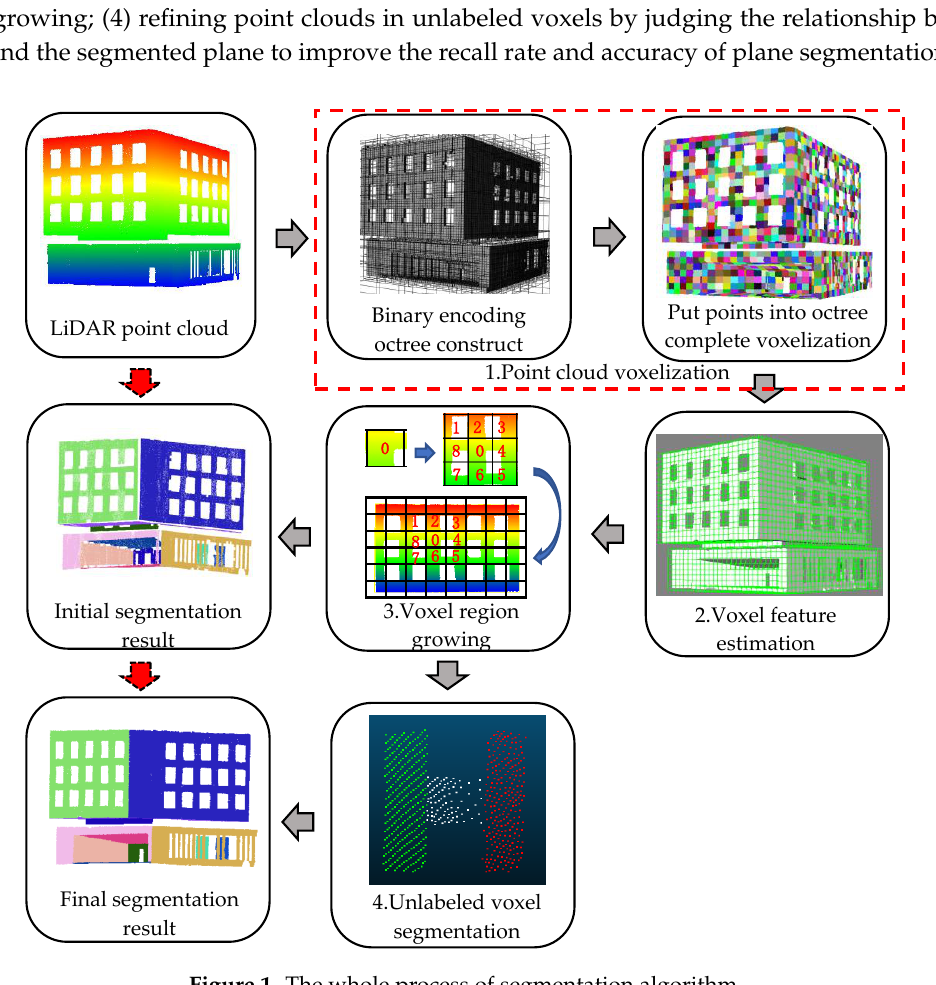
Figure 1. The whole process of segmentation algorithm.